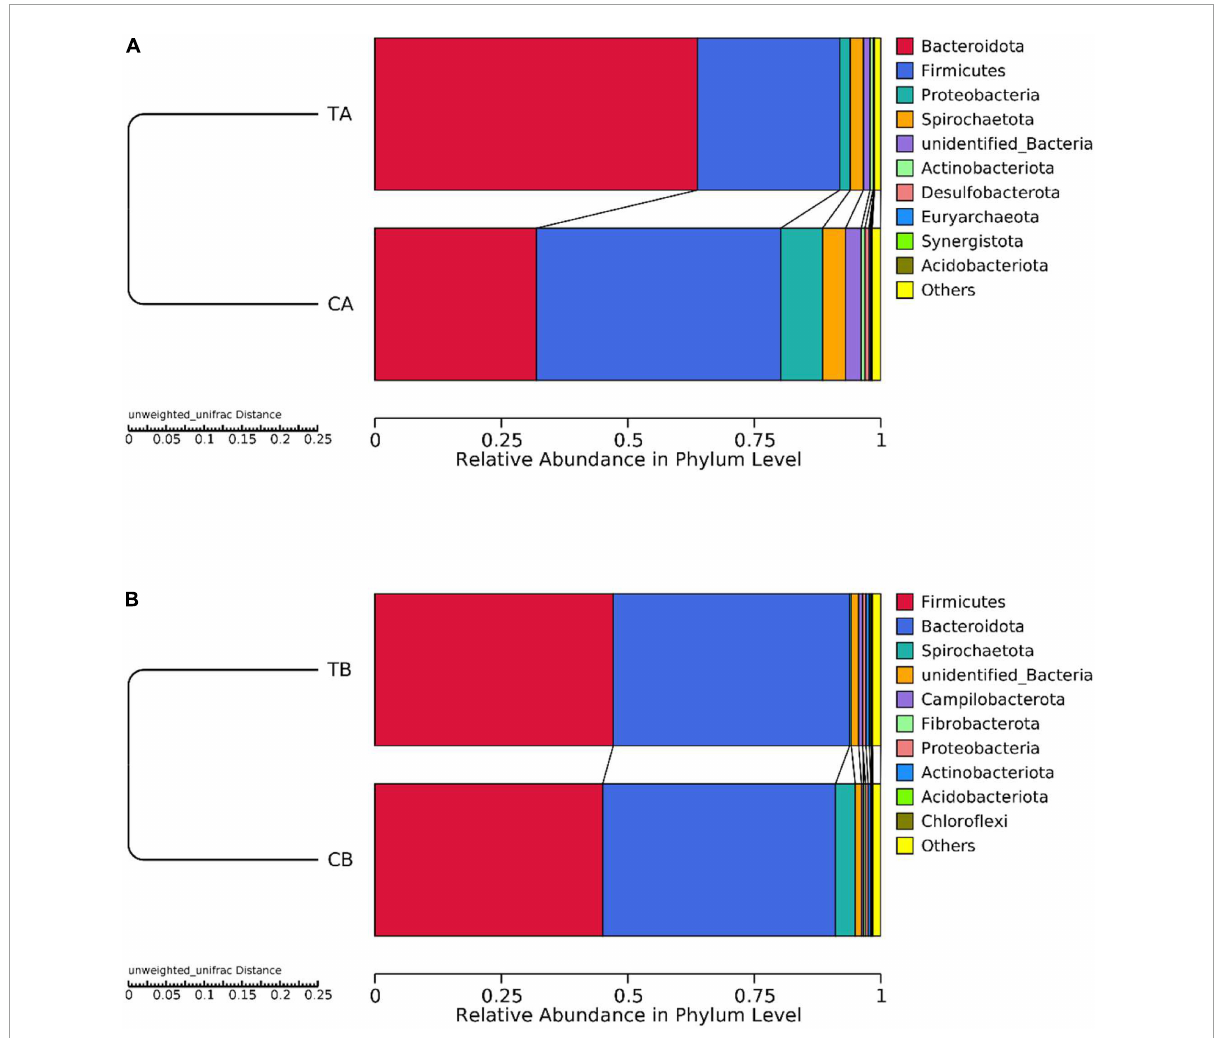
FIGURE4 Taxonomic distribution at phylum level for intestinal microbiota of piglets weaned on day 14 of age (14W) and day 28 of age (28W) at different sampling timepoints [day 28 of age (A) ; day 70 of age (B) ]. The “others” represents the sum of the relative abundance except the top 10 in the figure. CA group was defined as the sample from piglets in 28W group at the timepoint of day 28 of age. TA group was defined as the sample from piglets in 14W group at the timepoint of day 28 of age (A) . CB group was defined as the sample from piglets in 28W group at the timepoint of day 70 of age. TB group was defined as the sample from piglets in 14W group at the timepoint of day 70 of age (B)